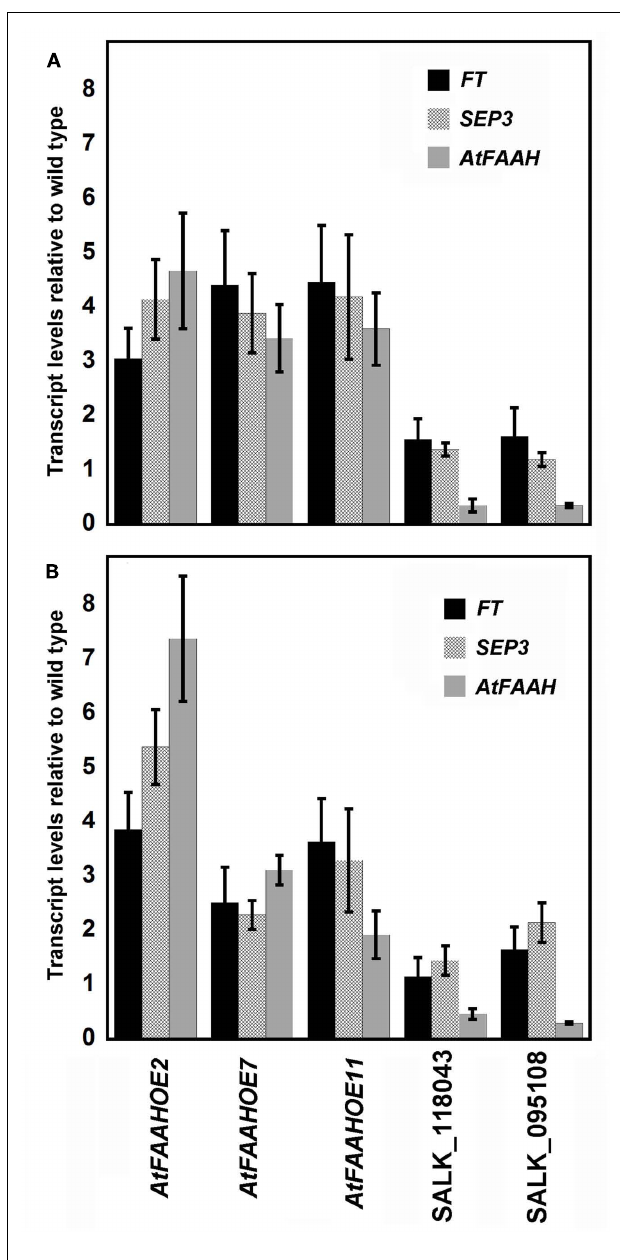
FIGURE 4 | Relative expression profiles of FT , SEP3 , and AtFAAH in three AtFAAH overexpressors and two AtFAAH knockouts (SALK_118043 and SALK_095108) determined by quantitative RT-PCR. Fourteen day-old plants grown under short days (A) and long days (B) . Values plotted were normalized to 18S rRNA and are the mean of four biological replicates ± SE.